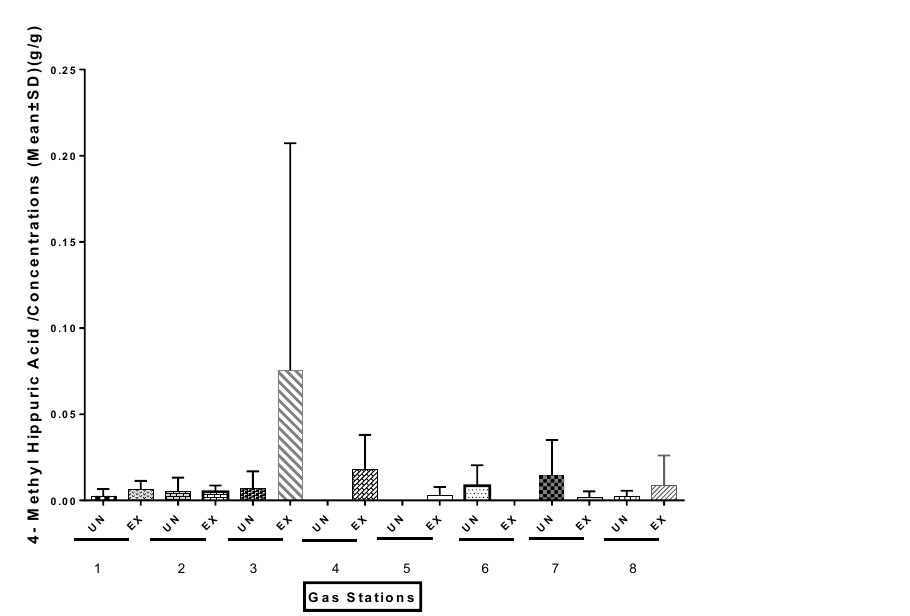
Figure 4. The Mean Concentrations of 4-MHA (g/g creatinine) at Each Gas Station in the Control and Exposed Groups Regardless of the Season Variable (UN: control group; EX: exposure group)